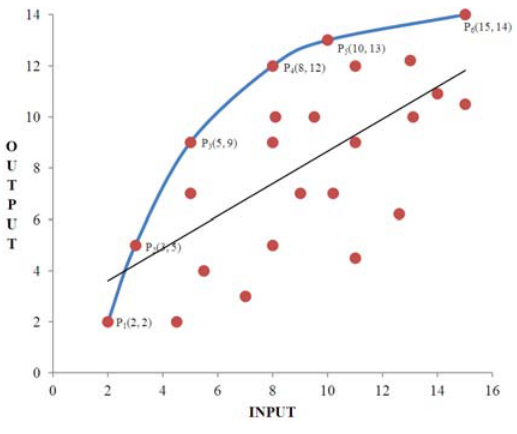
Fig. 1. Comparison of DEA and regression Source: Charnes, Cooper, Lewin and Seiford (1994, p.